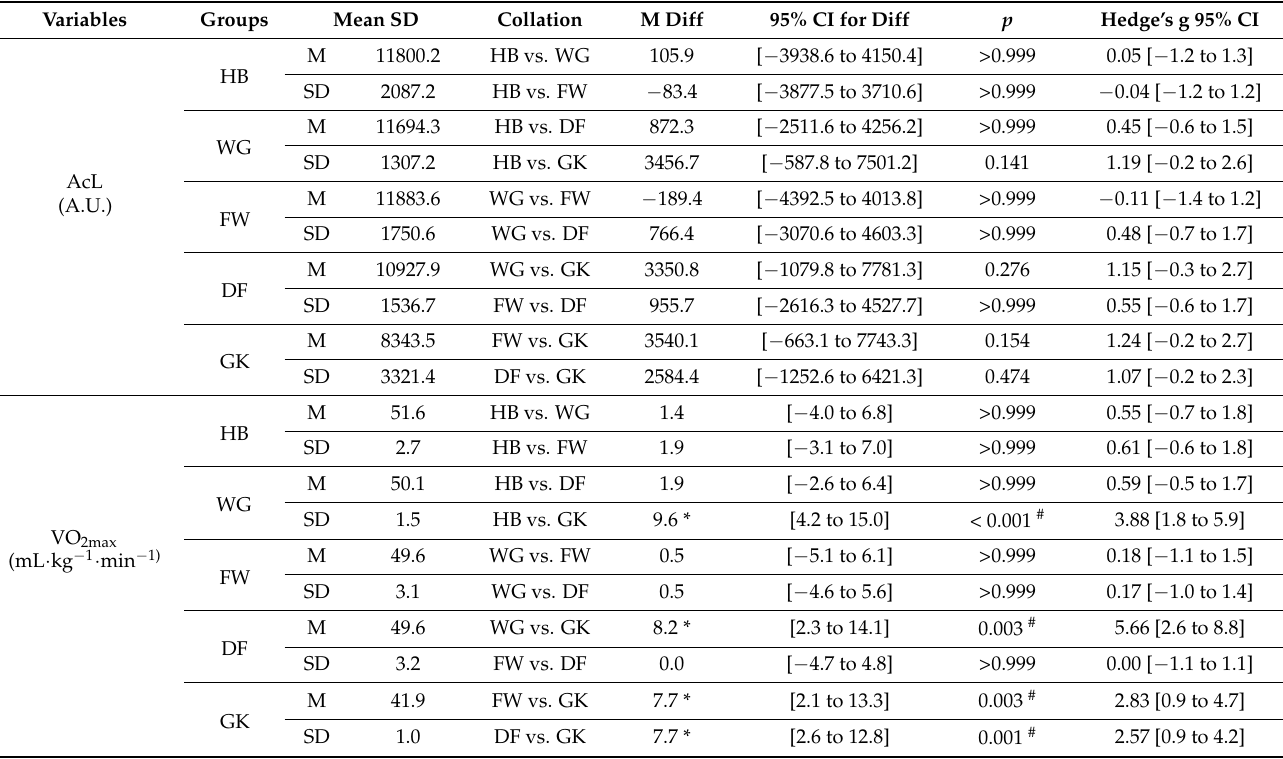
Table 3. Between-group comparisons for accumulated load and fitness parameters between playing positions in